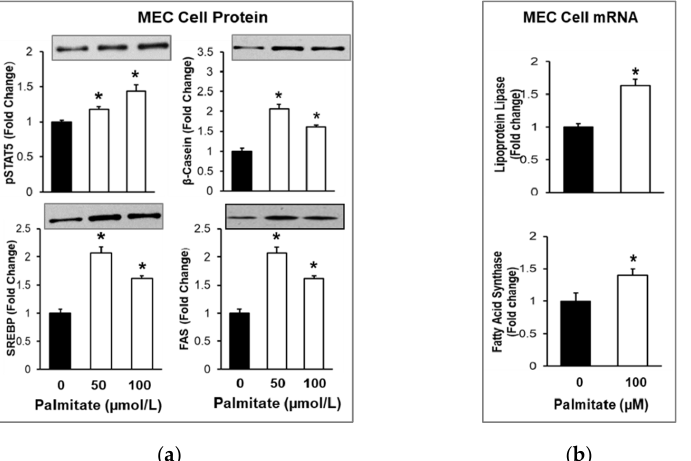
Figure 5. Effects of Palmitate on Milk Protein β -casein and Lipid Synthesis in Mammary Epithelial Cells. MECs were treated with varying doses of palmitic acid added to the lactation medium in the basolateral chamber for 48 h. Cellular MECs were analyzed for ( a ) protein expression (representa- tive immunoblot shown) and ( b ) mRNA expression of milk lipid regulators. Each treatment was performed in quadruplicate, and differences between treated and untreated MECs were compared using ANOVA with Dunnett’s post-hoc test. Values are fold changes (Mean ± SE); * p < 0.001 treated vs. untreated MECs.